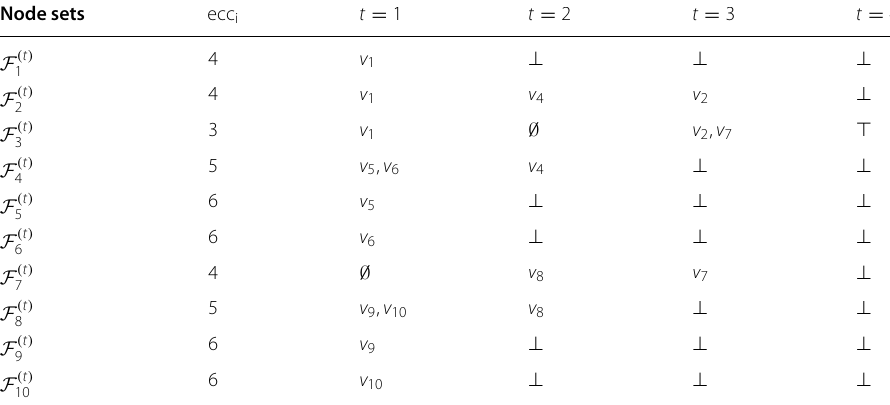
Table 1 Table indicating pruned nodes, identified at each node after each iteration using the graph in Fig.